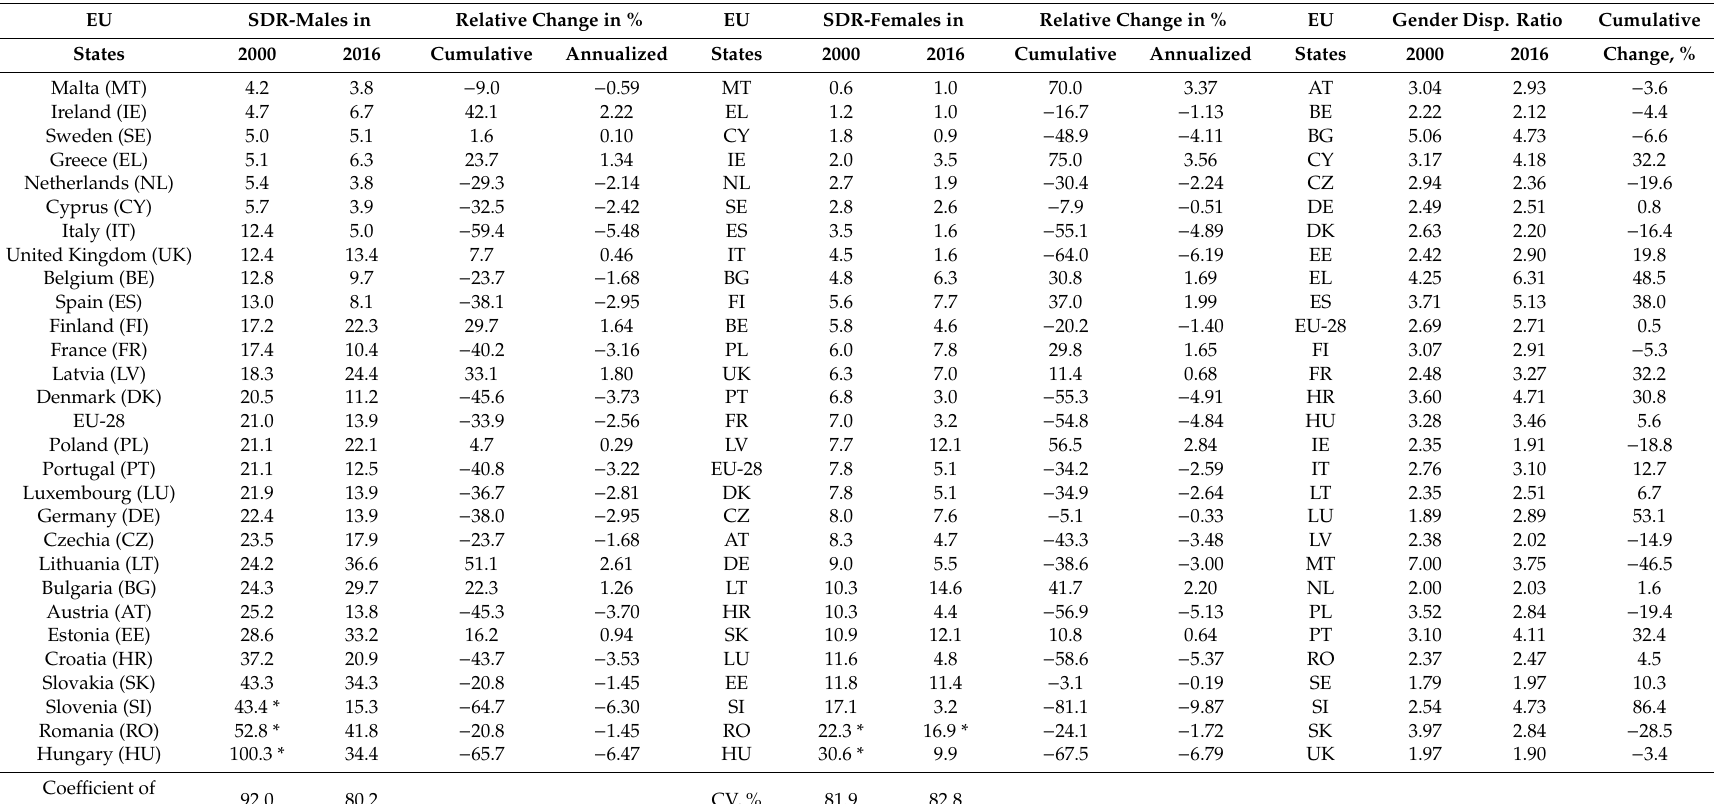
Table 5. Premature SDR for chronic liver disease in the EU countries in 2000 and 2016 1